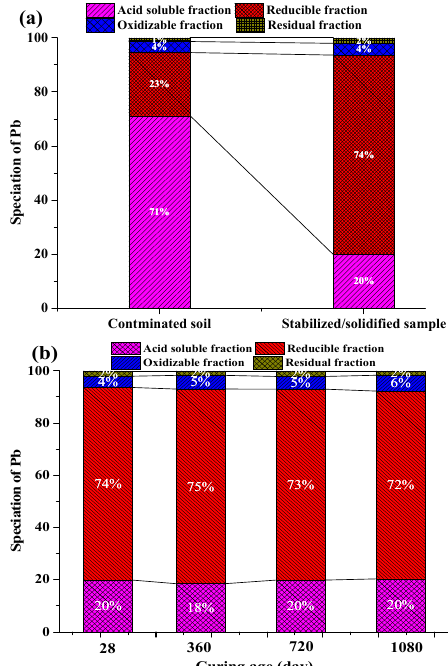
Figure 2. Lead speciation in untreated soil and S/S monoliths cure for different ages: ( a ) potentially toxic-element speciation change, before and after S/S treatment (cured for 28 days); ( b ) metal speciation variation in S/S samples cured for different periods.